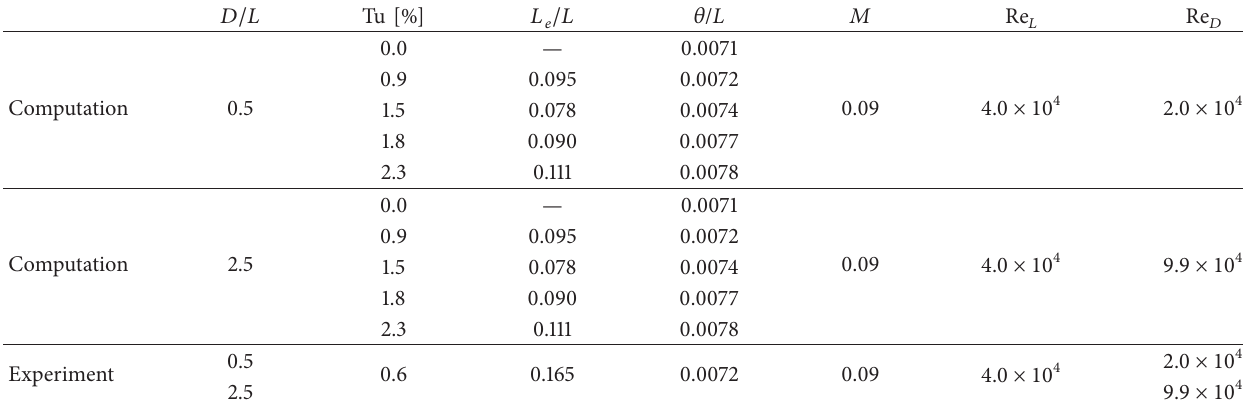
Figure 1: Configurations for flows around two-dimensional cavity. (a) 𝐷/𝐿 = 0.5 . (b) 𝐷/𝐿 = 2.5 . Table 1: Computational and experimental